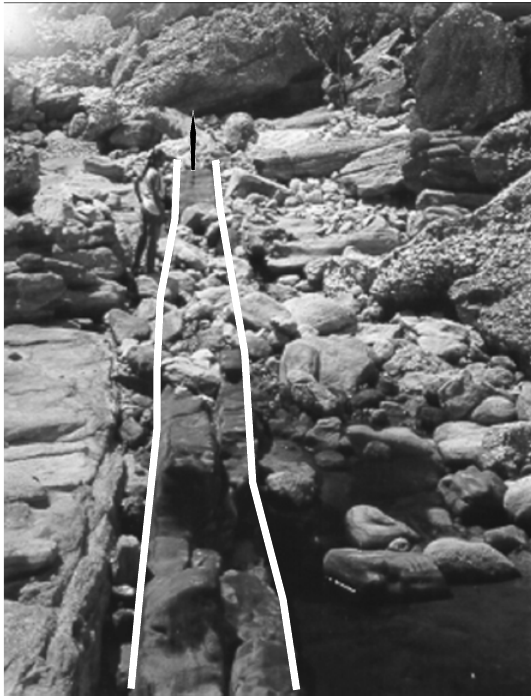
Fig. 3 – Outcrop of dike cross-cutting sandstones of Tombador Forma- tion. The field relationships show clearly the dike has igneous